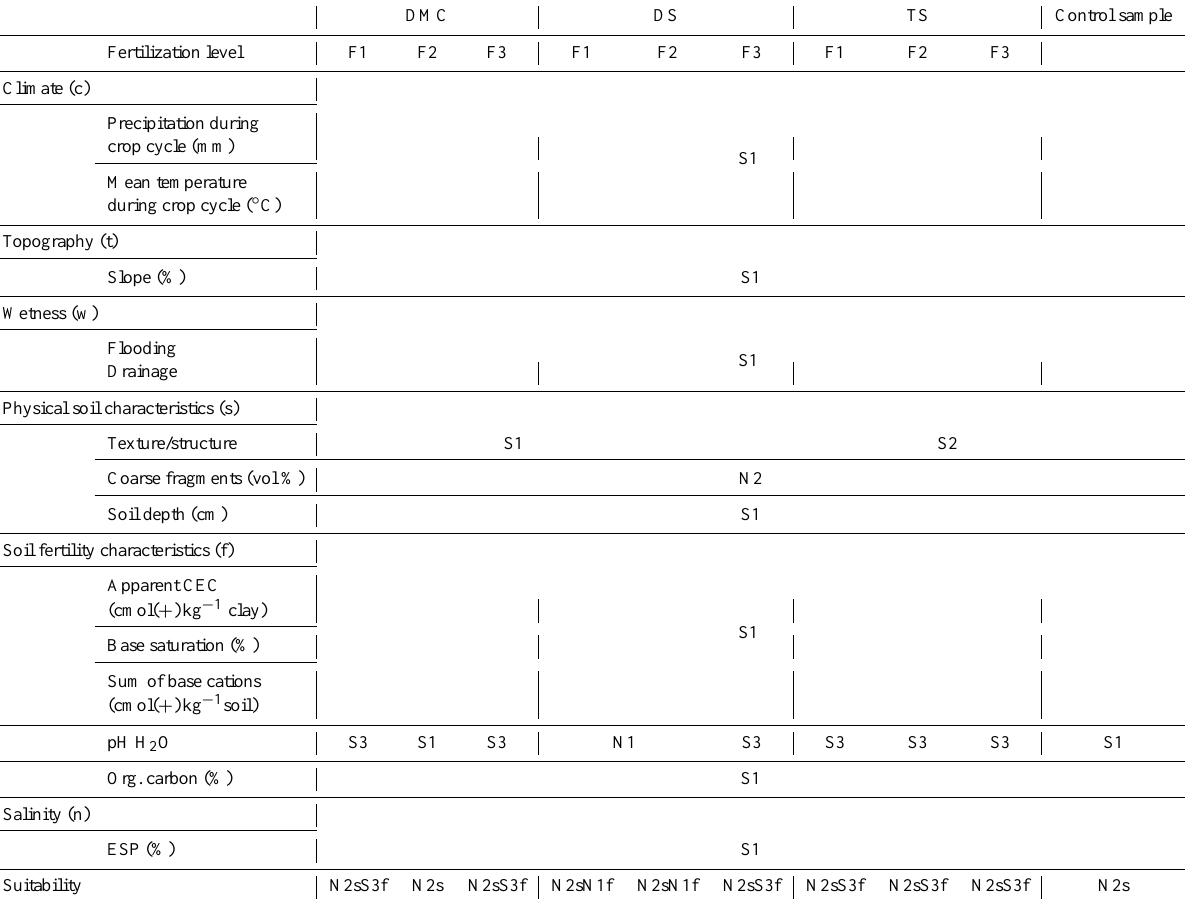
Table 5. Land suitability